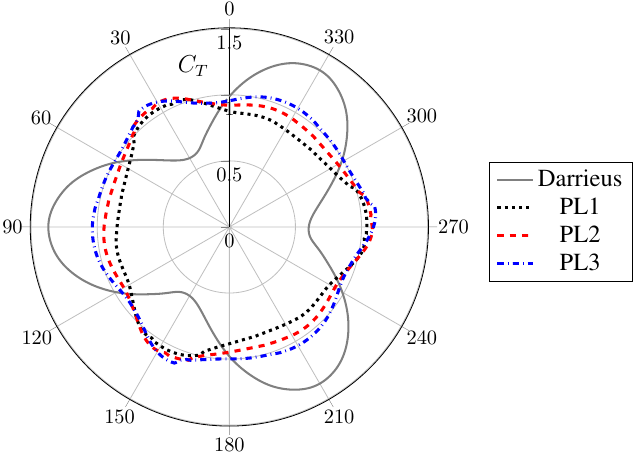
Figure 13. Thrust coefficient ( C T ) for the Darrieus and the pitching law cases, λ = 3. Table 3. Thrust coefficient: average ( C T ) and ripple factor ( C T and variable pitch